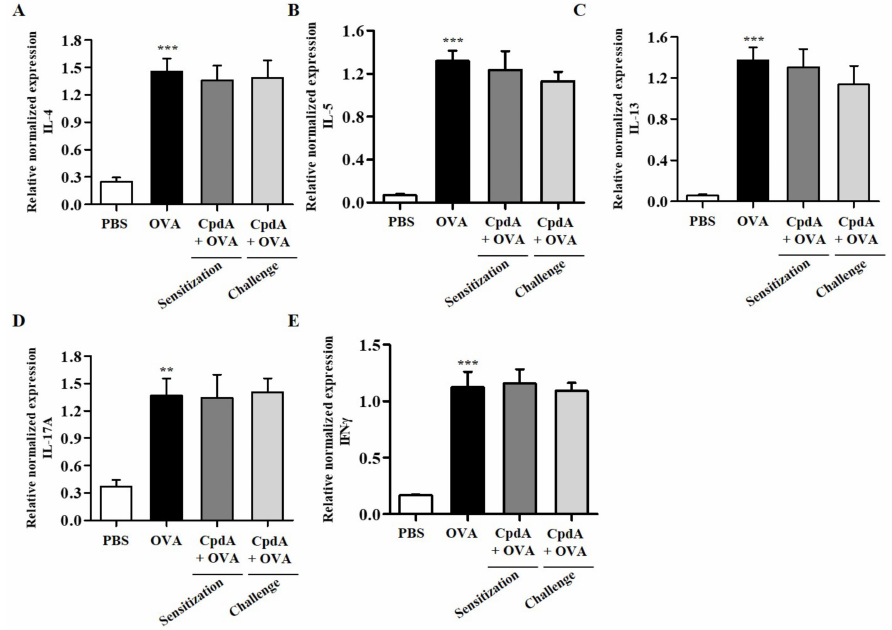
Figure 9. Effect of compound A on expression levels of T H 2, T H 17, and T H 1 cytokines in the lung tissues of OVA-induced asthma in FFA4-KO mice. Analysis of mRNA expression of T H 2 (IL-4, IL-5, and IL-13), T H 17 (IL-17A), and T H 1 (IFN- γ ) cytokines in lung tissues of OVA-induced and compound A-treated FFA4-KO mice. Relative mRNA levels of cytokines were quantified as ratios to GAPDH transcript levels. ( A ) IL-4, ( B ) IL-5, ( C ) IL-13, ( D ) IL-17A, and ( E ) IFN- γ . The results are presented as mean ± SEM ( n = 5). ** p < 0.01, *** p < 0.001 vs. the PBS-treated